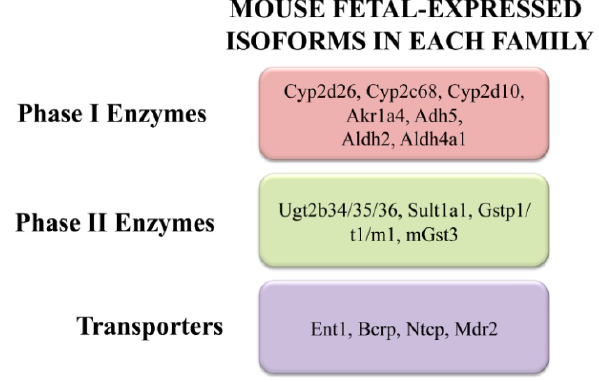
Figure 2. Enzymes and transporters expressed in the fetal mouse liver. RNA-sequencing studies have quantified the absolute mRNA expression of drug metabolizing and transport genes in the mouse fetal liver two days prior to birth